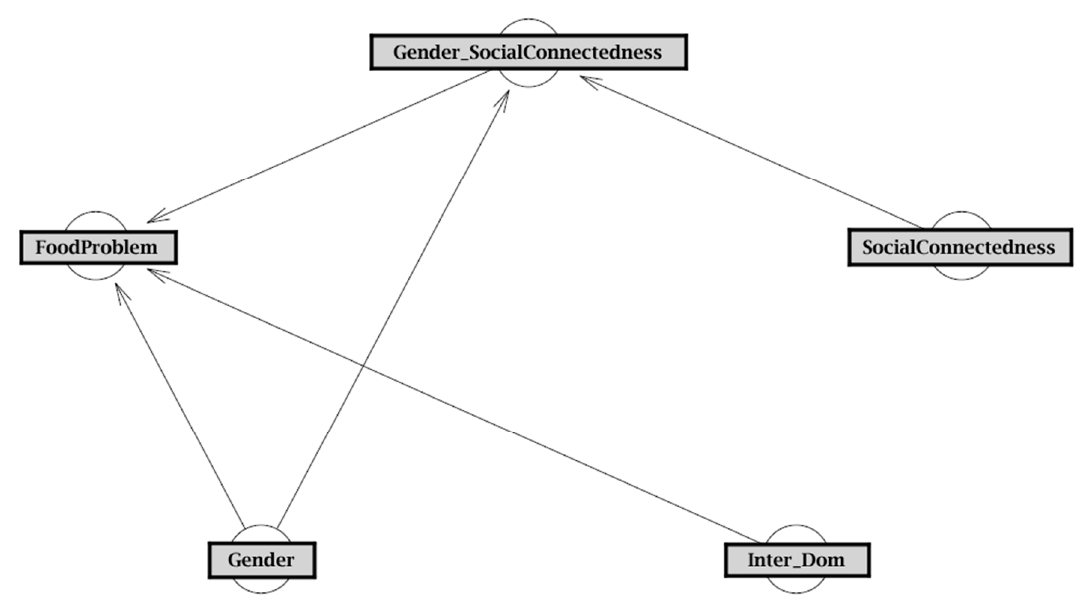
Figure 1. The model’s logical network.